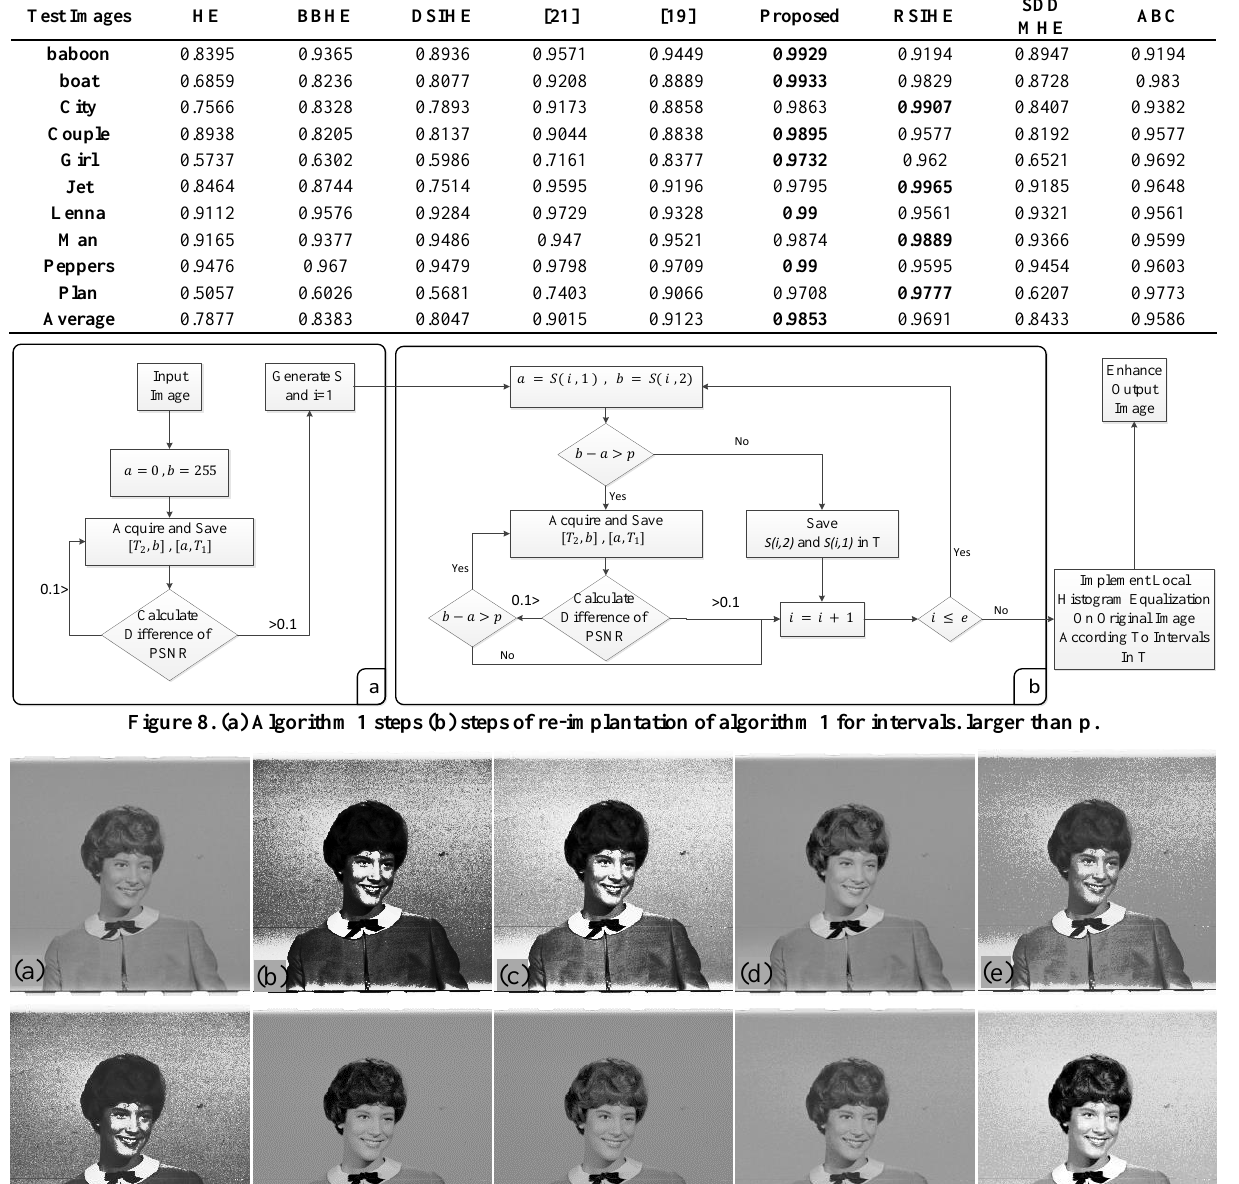
Table 5. Compare various method with FSIM.